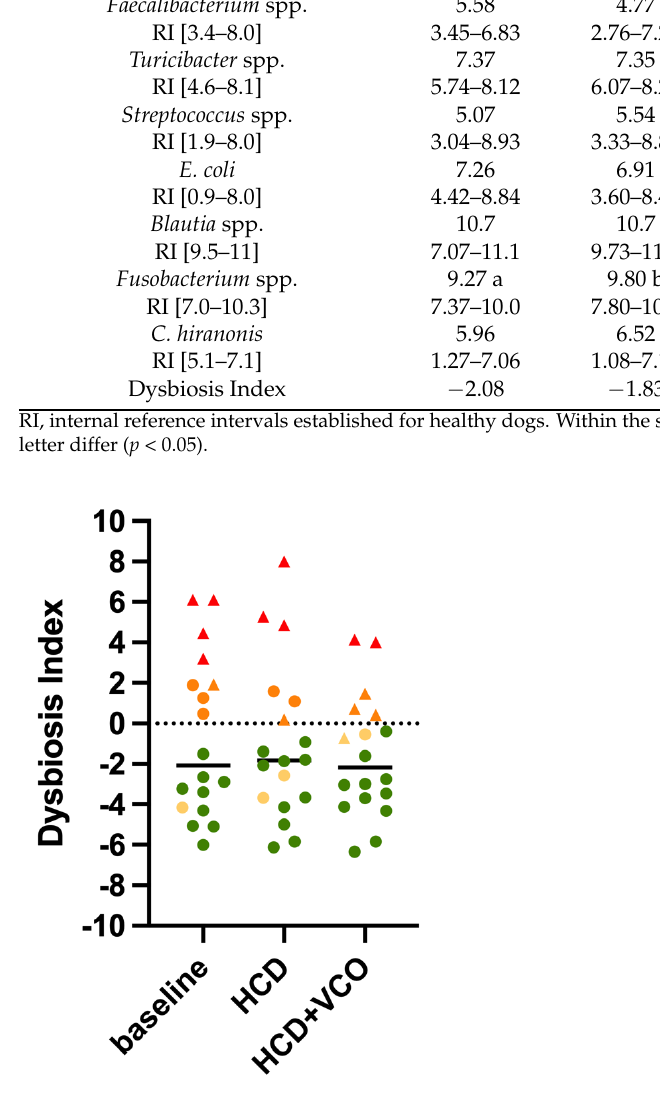
Figure 2. Dot plots showing the Dysbiosis Indexes (DIs) of canine fecal samples collected from dogs during the first visit (baseline), after receiving a home-cooked diet for 7 days (HCD), and after supplementation with virgin coconut oil (HCD + VCO). The black horizontal line represents the median. Interpretations for DI: <0 = normal; 0 − 2 = mildly increased; >2 = significantly increased. Graphic representations of the alterations (intended as deviation from the internal reference interval) of the selected bacterial populations, based on qPCR: green dots, normal; yellow dots, minor changes (defined as DI < 0 but some bacterial taxa outside their respective reference interval); orange dots, mild-to-moderate changes; red dots, significant changes. The triangles represent dogs with low C. hiranonis